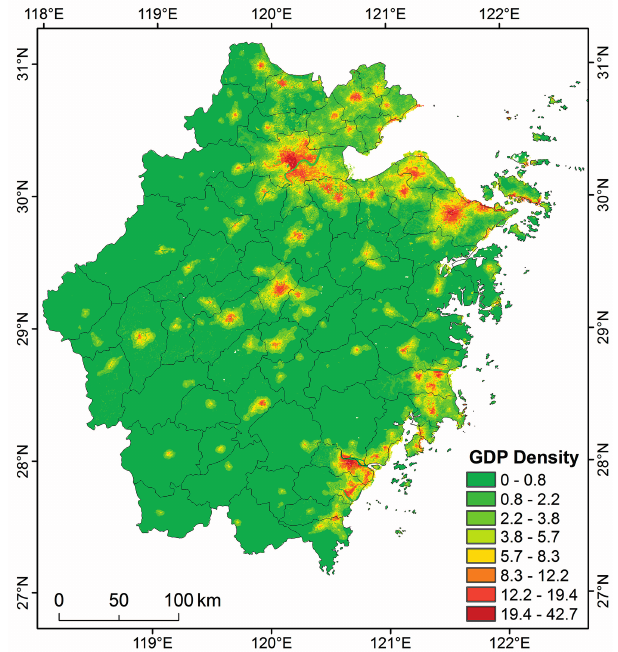
Figure 5. GDP density map of Zhejiang Province in 2009 (unit: million CNY/0.0625 km 2